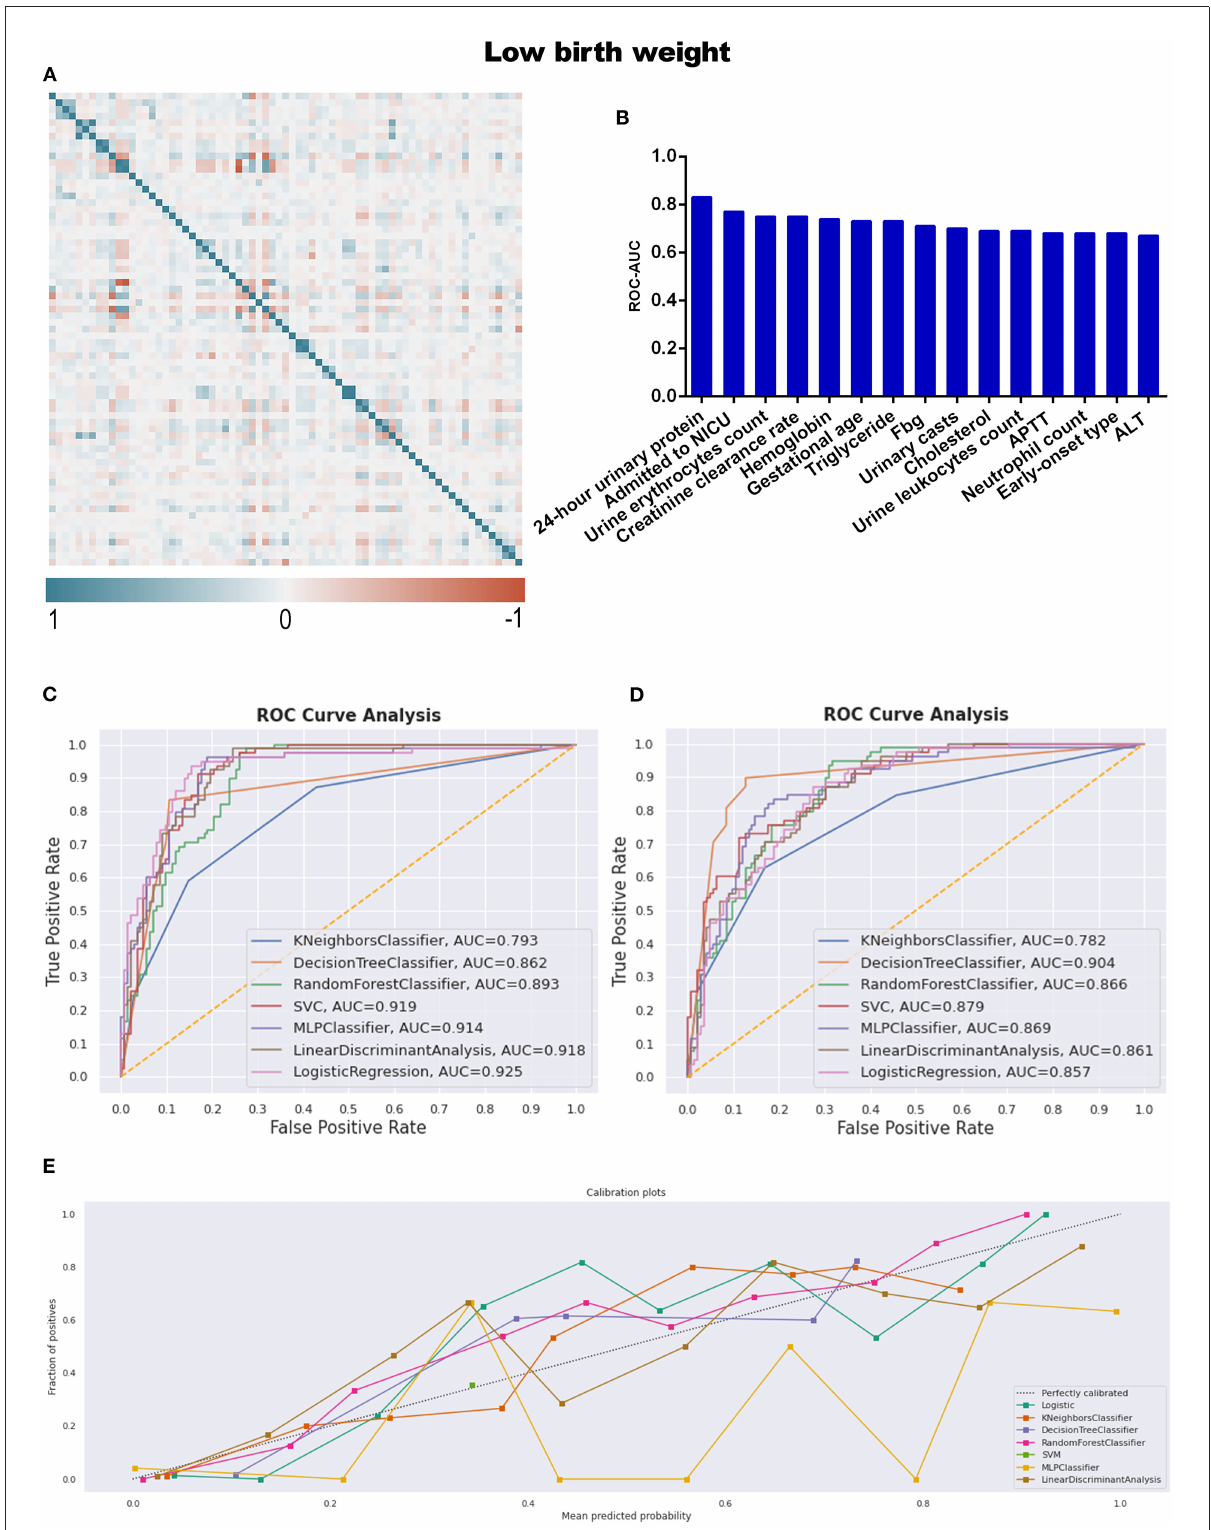
FIGURE6 (A) The generated heat map according to correlation analysis to screen independent variables for adverse events; (B) feature selection of Top 15 adverse outcomes predictive variables according to the value of AUC calculated by DT algorithm; (C) the ROC-AUC values of machine learning and logistic regression predictive models developed from the imputed dataset; (D) the AUC values of models developed from the dataset without imputation; (E) the calibration curve generated from the models developed from imputed dataset. Referring to the adverse outcome of low birth